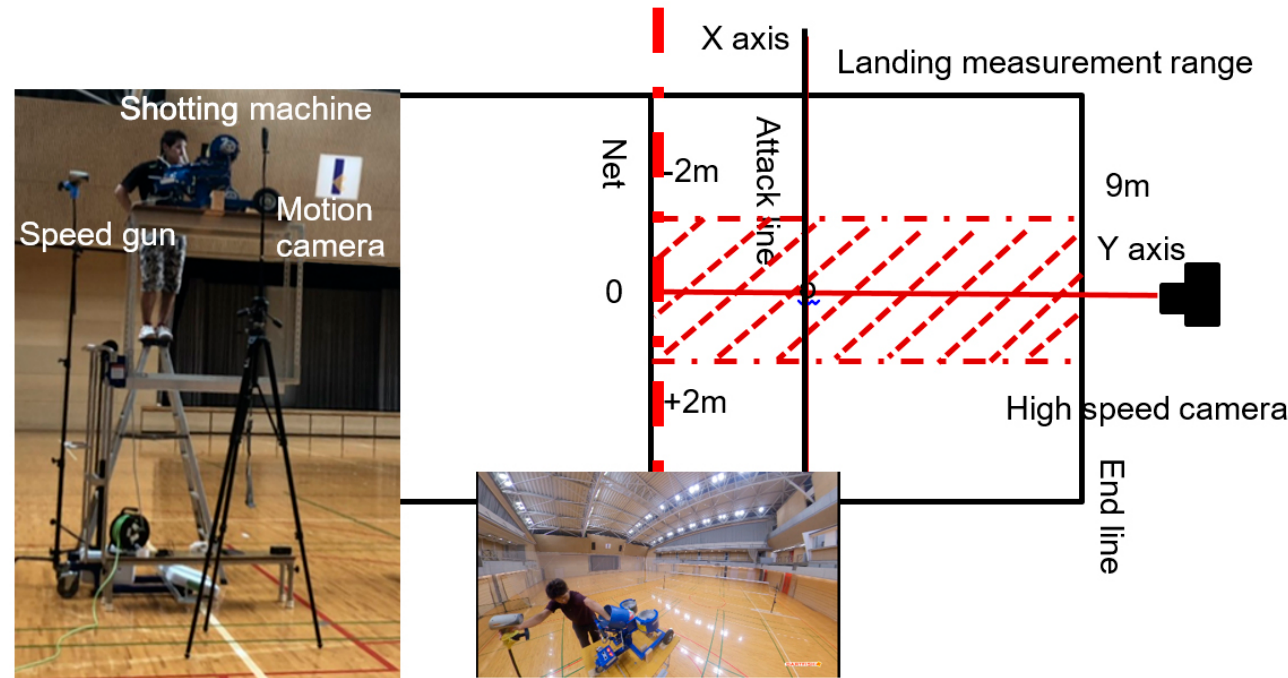
Figure 3. Outline of ejection experiment.